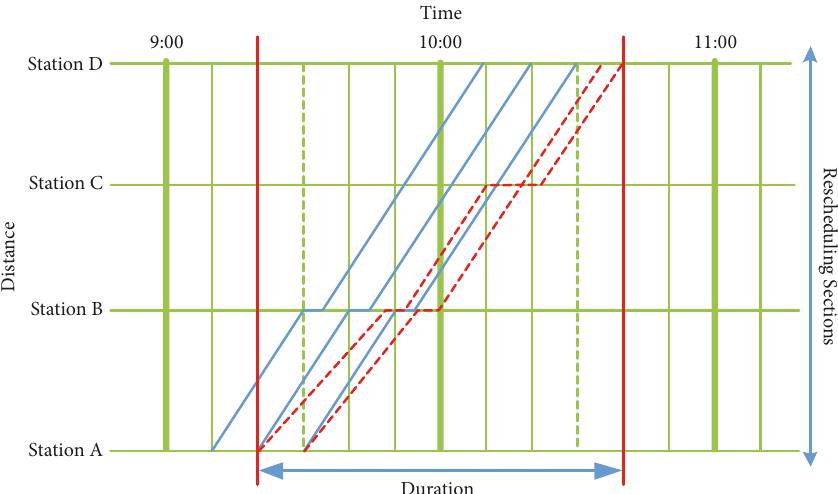
Figure 2: The rescheduled time-distance diagram based on multistrategies (the retiming, reordering, and stop pattern adjusting).